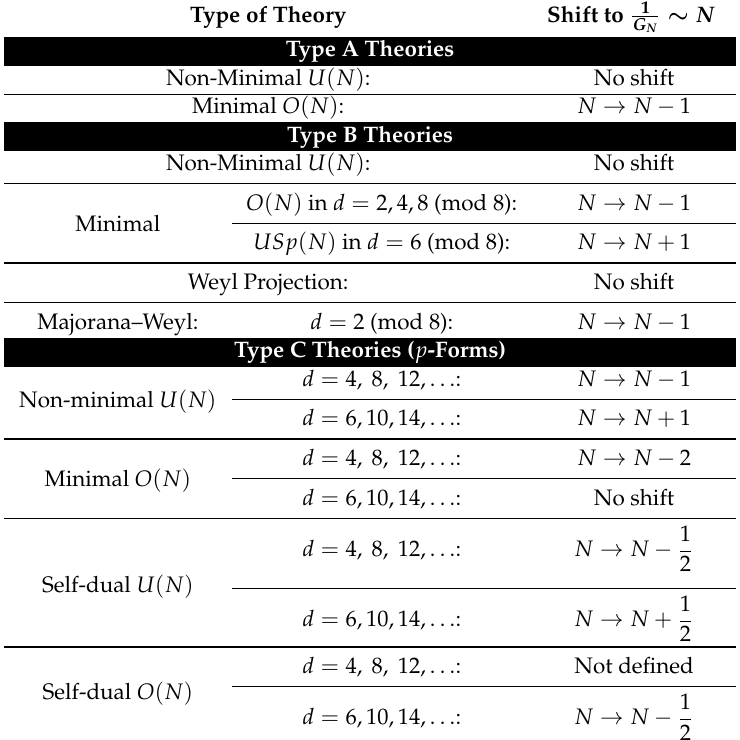
Table 1. Summary of results of one-loop calculations for even d > 0. By no shift, we mean that there are no shifts to the relation G N ∼ 1/ N due to one-loop free energy of the particular theory. Results for Type A theories taken from